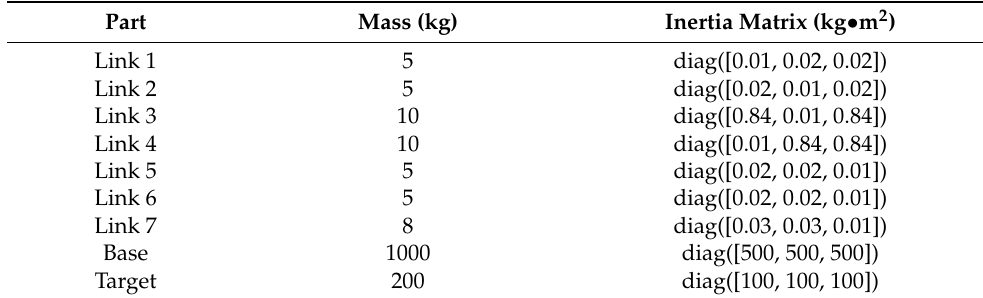
Figure 12. Seven-DOF free-floating space robot capturing tumbling target. Table 5. Dynamics parameters of 7-DOF free-floating space robot and the target.